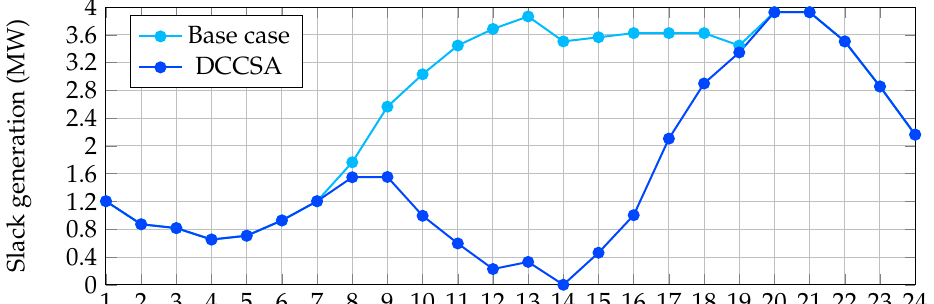
Figure 5. Impact of PV integration in the 33-node test system.